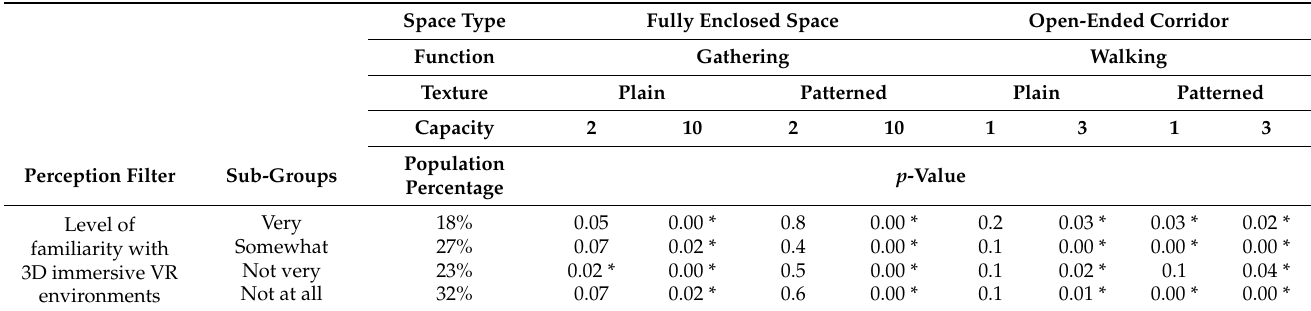
Table 9. Familiarity with 3D immersive Virtual Reality environments perception filter and com- parisons of space size variations between IVRIE and DT systems.